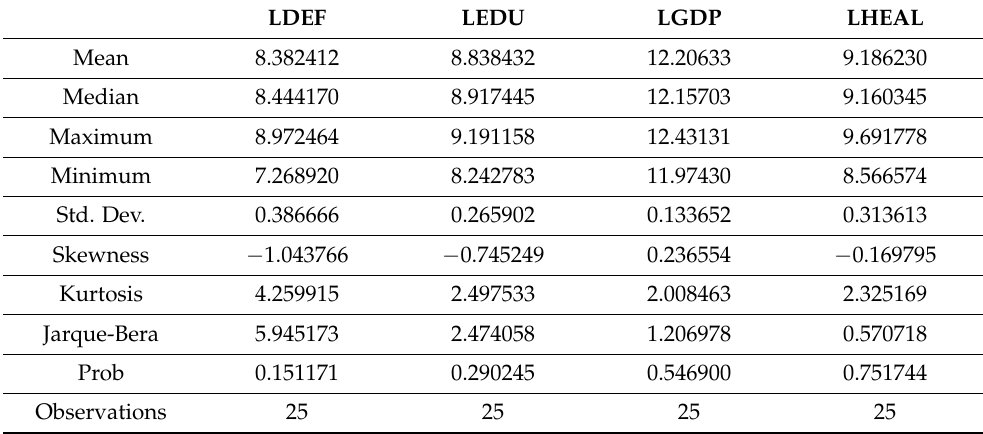
Table 1. Descriptive Statistics.